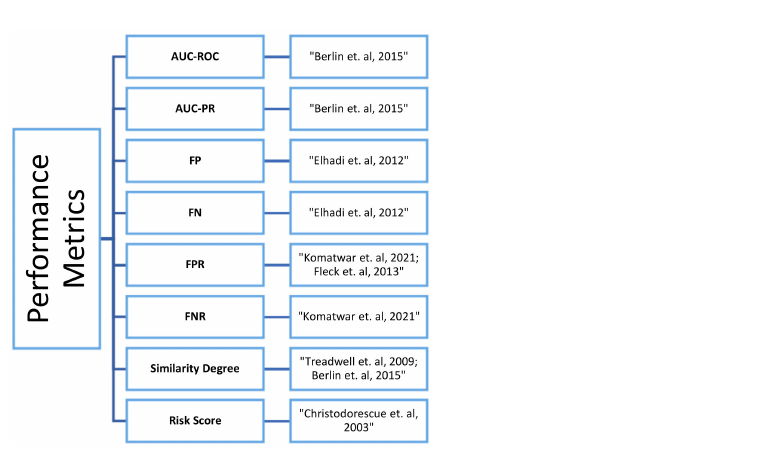
Figure 3. Performance Metrics Used in Literature Proposing Primitive Methods for Malware